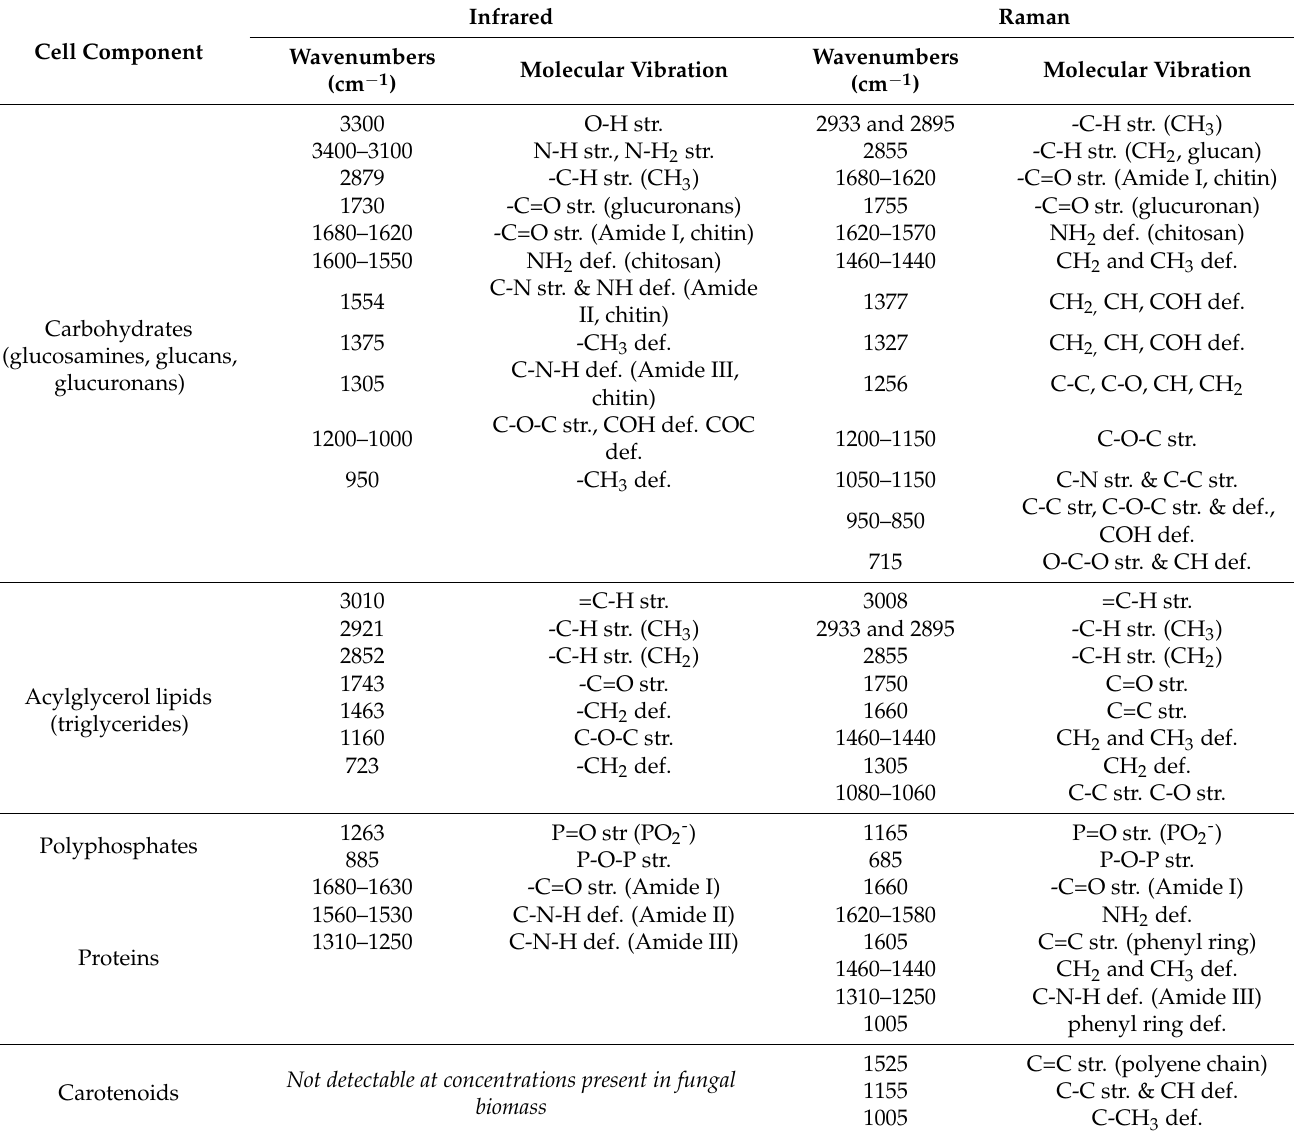
Table 1. Assignments of infrared and Raman bands: str.—stretching and def.—deformation